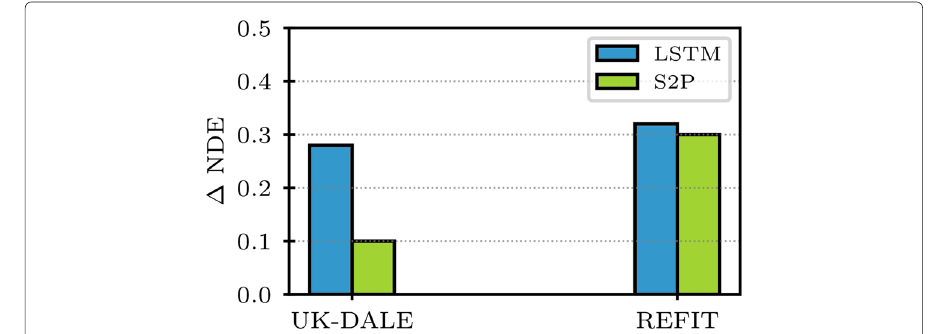
Fig. 9 Performance gap with regard to NDE for washing